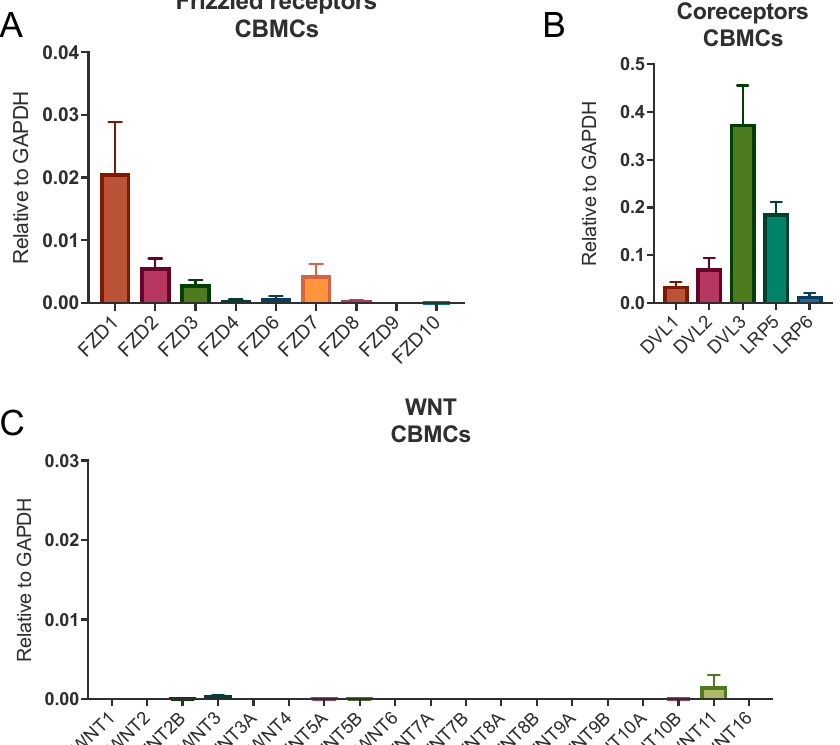
Figure 1. mRNA expression of components of the Wnt signaling system in human mast cells. mRNA was extracted from human cultured CBMCs and qPCR was performed for FZD 1–10 ( A ), DVL1-3 and LRP5 / 6 ( B ), and all 19 WNTs ( C ) using a Human WNT Pathway TaqMan Array. n = 3, means with